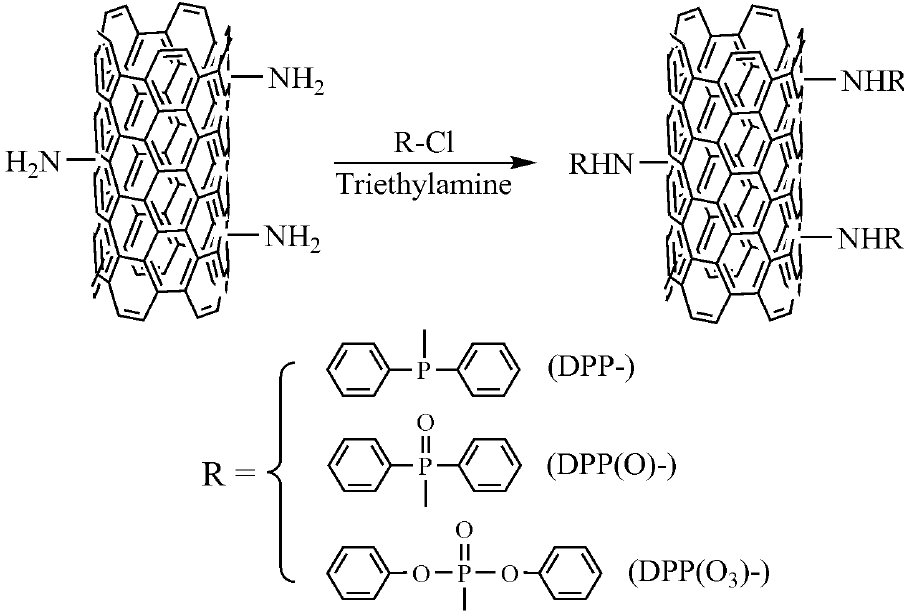
Figure 1. Schematic representation of the preparation route for covalently functionalized CNTs: DPP-A-CNT, DPP(O)-A-CNT, and DPP(O 3 )-A-CNT.